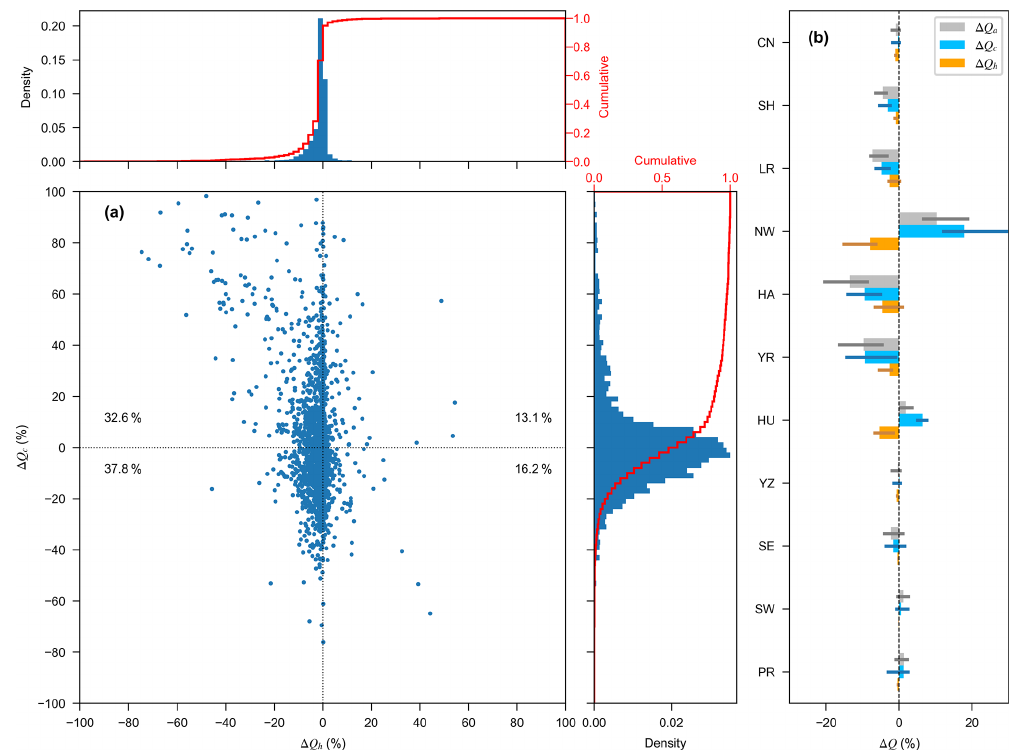
Figure 6. Relative MAF changes for river segments and basins. (a) Ensemble medians of MAF changes induced by climate change ( (cid:49)Q c ) versus those induced by DHI change ( (cid:49)Q h ) for river segments of China. Data points in (a) denote the values for individual river segments; the right histogram and the top histogram show the distributions of (cid:49)Q c and (cid:49)Q h , respectively. The numbers are the proportions of data points in each quadrant. (b) Spatially aggregated ensemble medians of total MAF changes ( (cid:49)Q a ) , MAF changes induced by climate change ( (cid:49)Q c ) , and MAF changes induced by DHI change ( (cid:49)Q h ) for individual basins and China; the error bars indicate the IQR in each